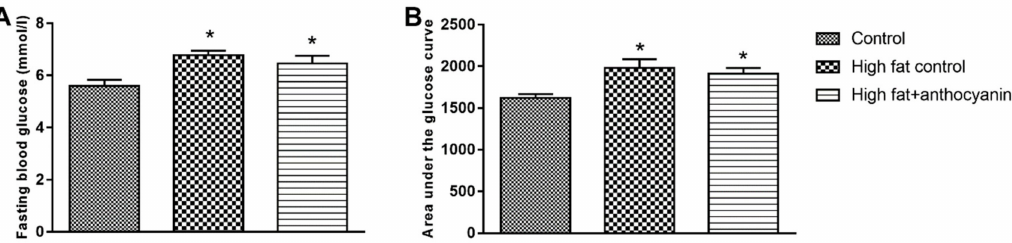
Figure 3. E ff ect of chronic anthocyanin treatment on the fasting blood glucose (Panel A ) and area under the glucose curve (Panel B ). The * indicates a significant di ff erence ( p < 0.05) from the control group.